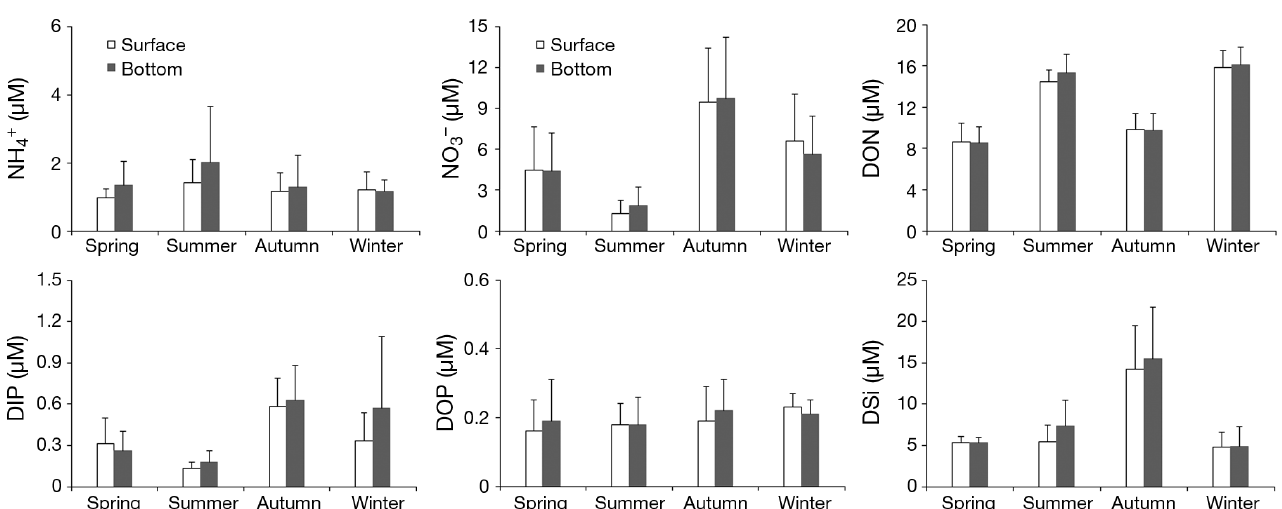
Fig. 5. Seasonal variations in nutrient concentrations (µM) in Sanggou Bay during the study period. DON: dissolved organic nitrogen, DIP (DOP): dissolved inorganic (organic) phosphorus, DSi: dissolved